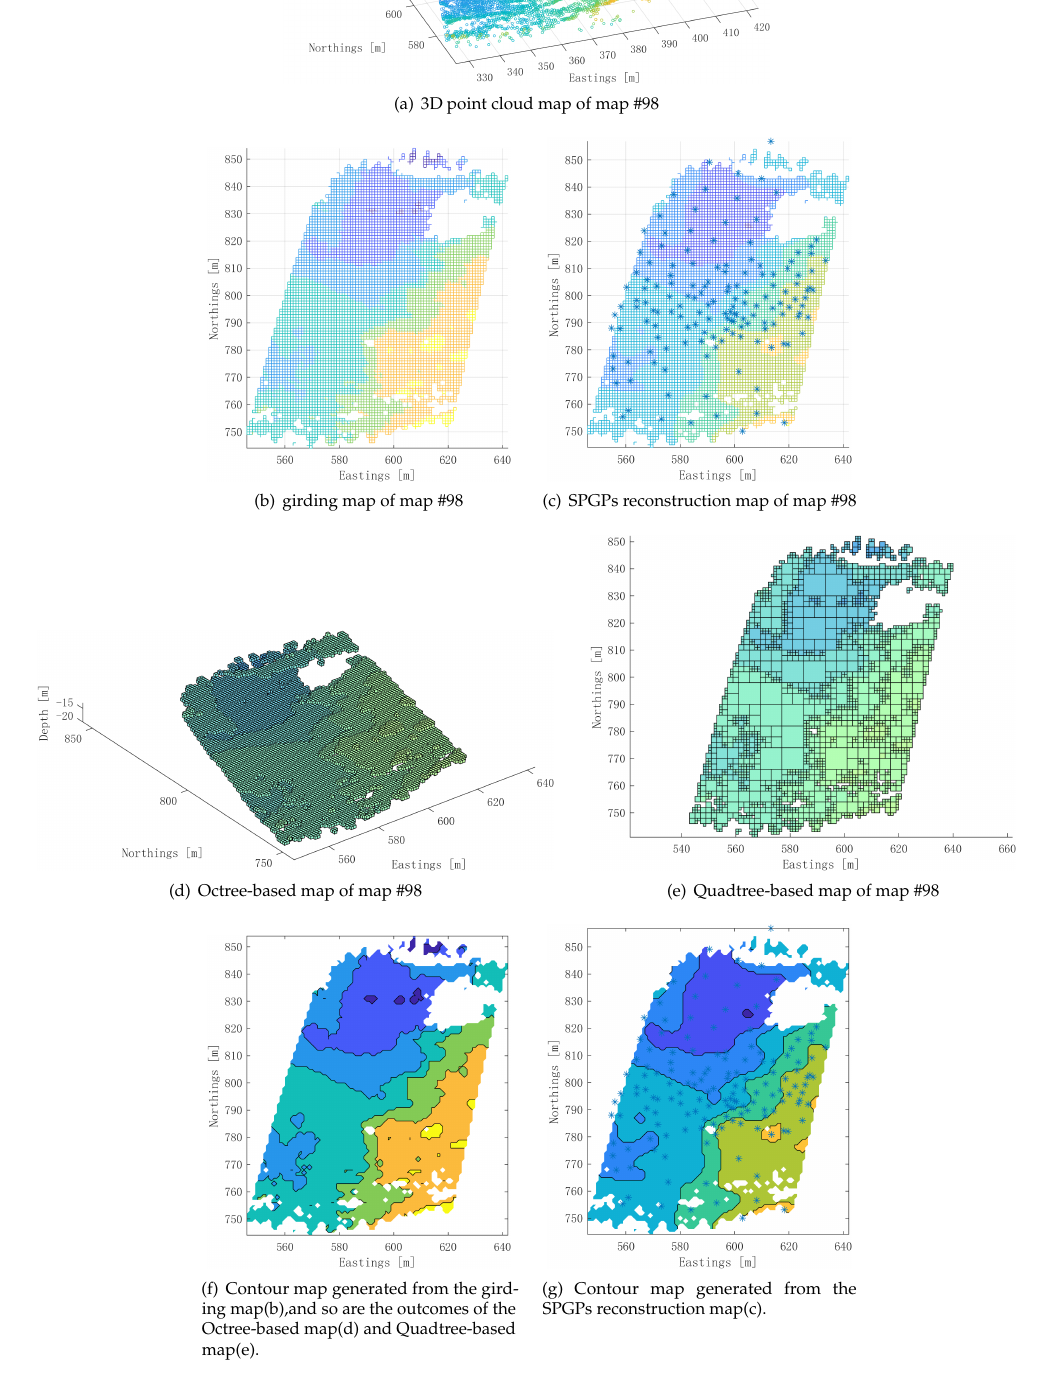
Figure 14. Experimental results of Map #98.